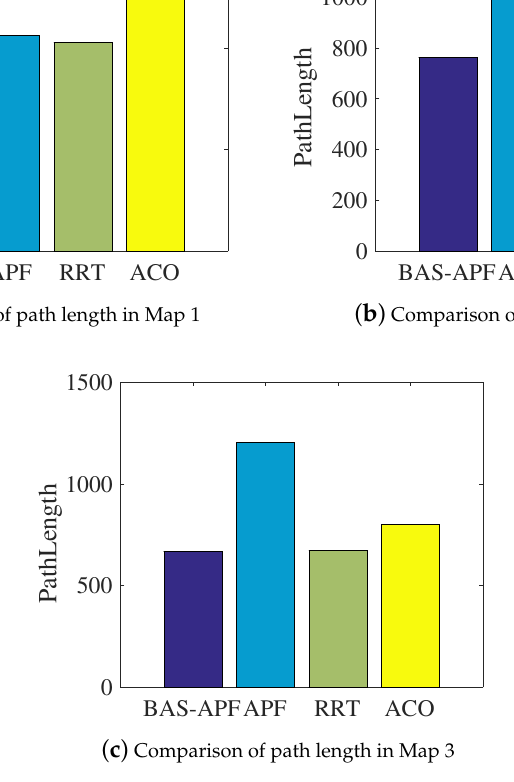
Figure 10. Comparison of path lengths on simulative